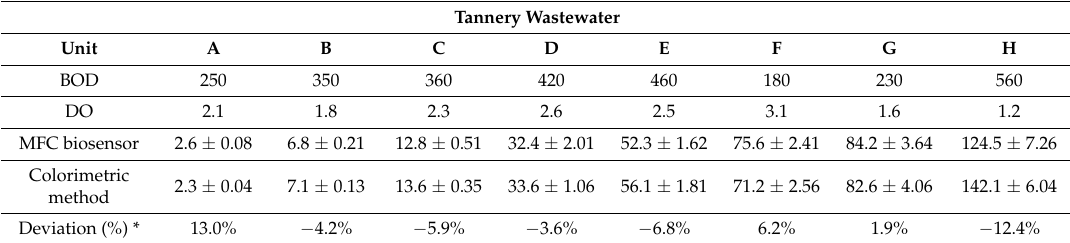
Table 1. Cr(VI) measurement from effluents of eight leather processing units by three-stage SCMFC biosensor in continuous-flow operation and colorimetric method in batch operation. Tannery Wastewater